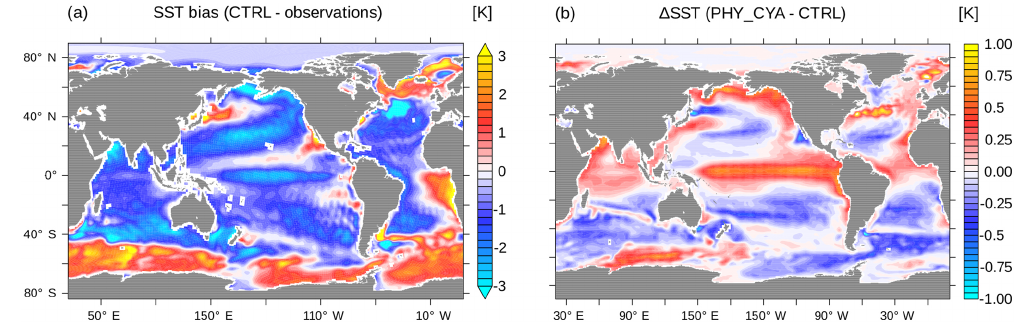
Figure 11. (a) SST (K) bias of CTRL compared to observations (PHC3 climatology). (b) Difference in SST (K) between PHY_CYA and